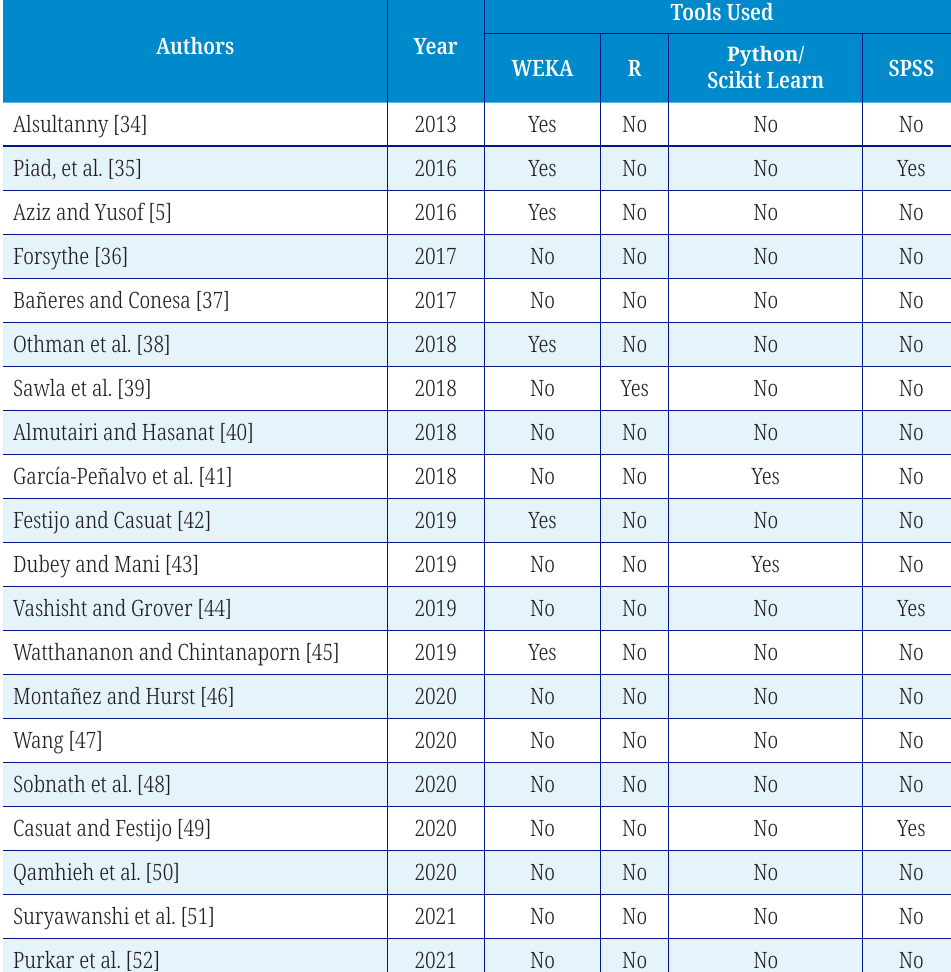
Table 7. Description of the tools applied to model